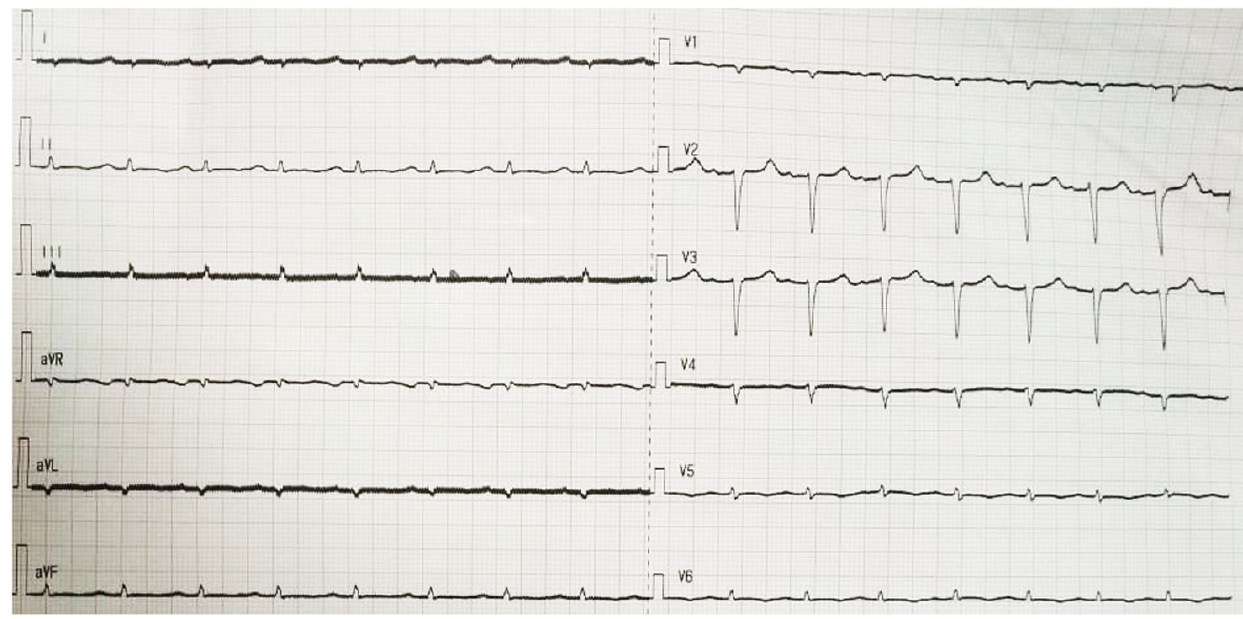
patient.Figure 1. Electrocardiogram (ECG) of the